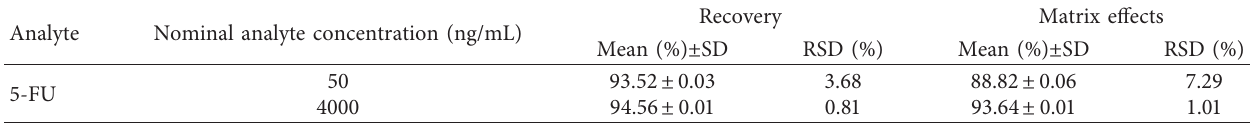
Table 4: Extraction recovery and matrix effect of 5-FU.